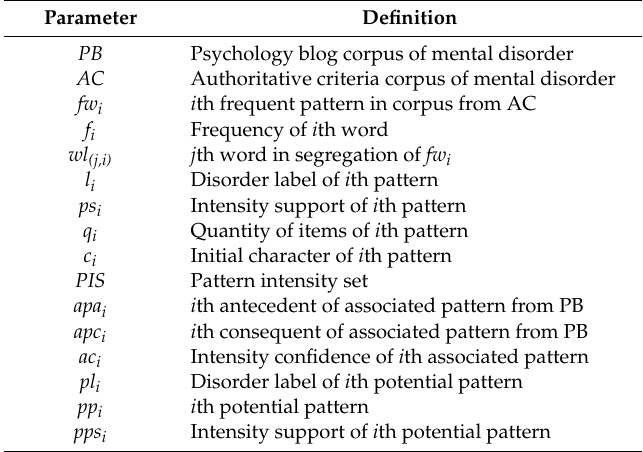
Table 1. Parameters of the sequential emotion analysis algorithm.